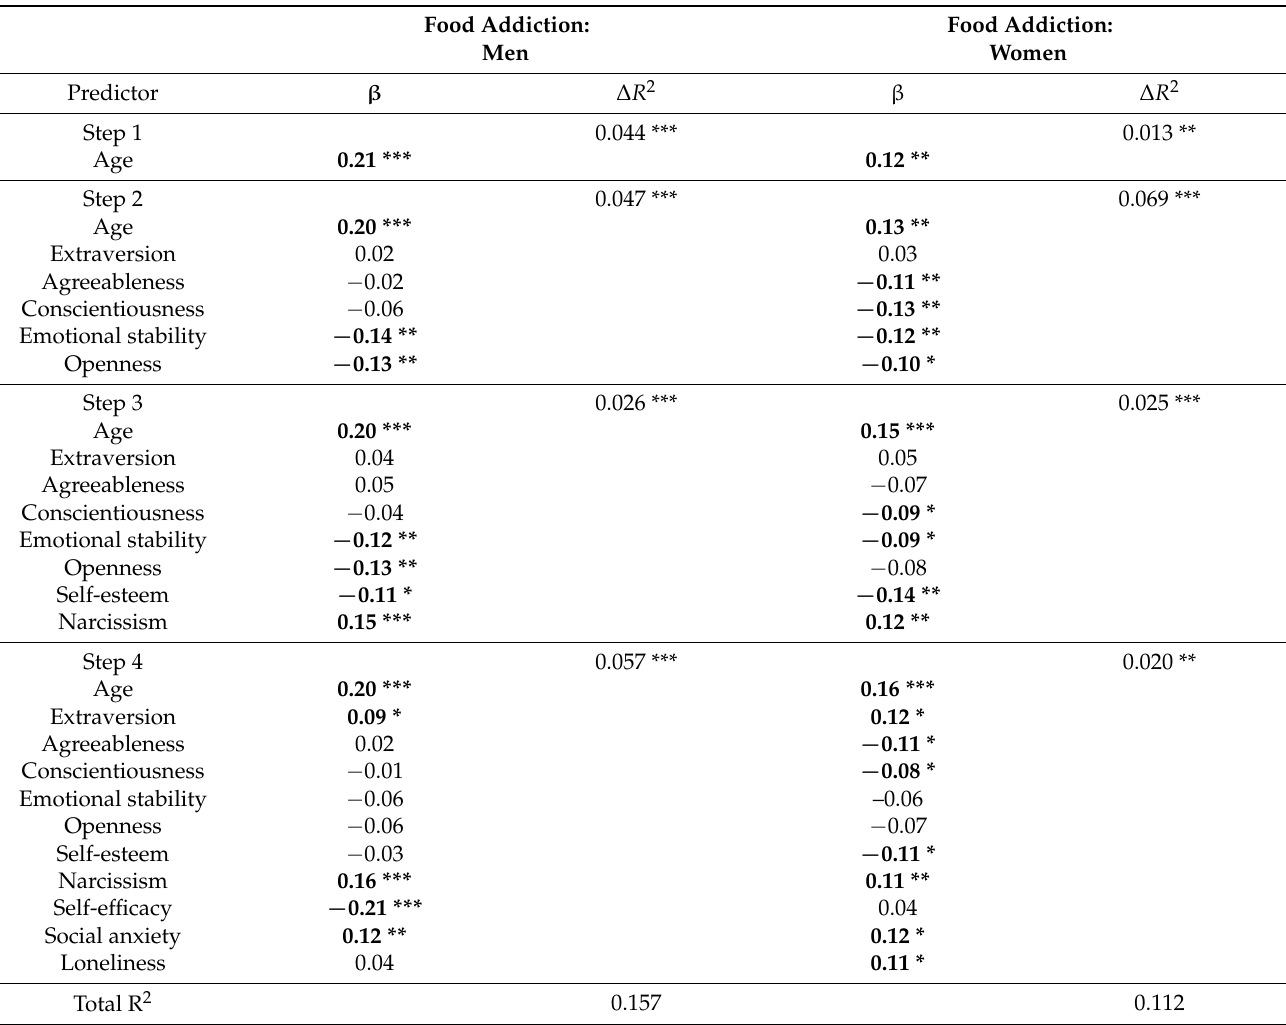
Table 5. Hierarchical multiple regression analysis predicting food addiction among men ( n = 546) and women ( n = 601). Food